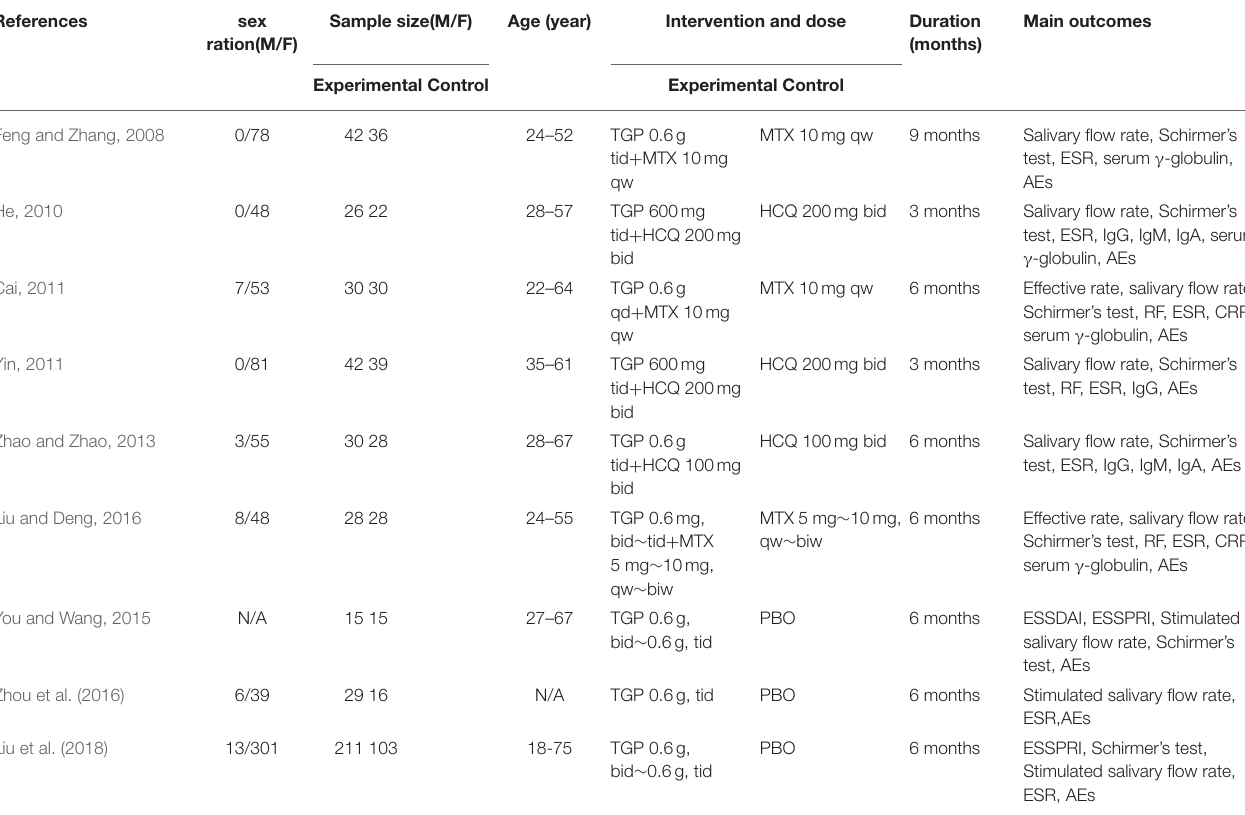
TABLE 1 | The characteristics of the included trials.